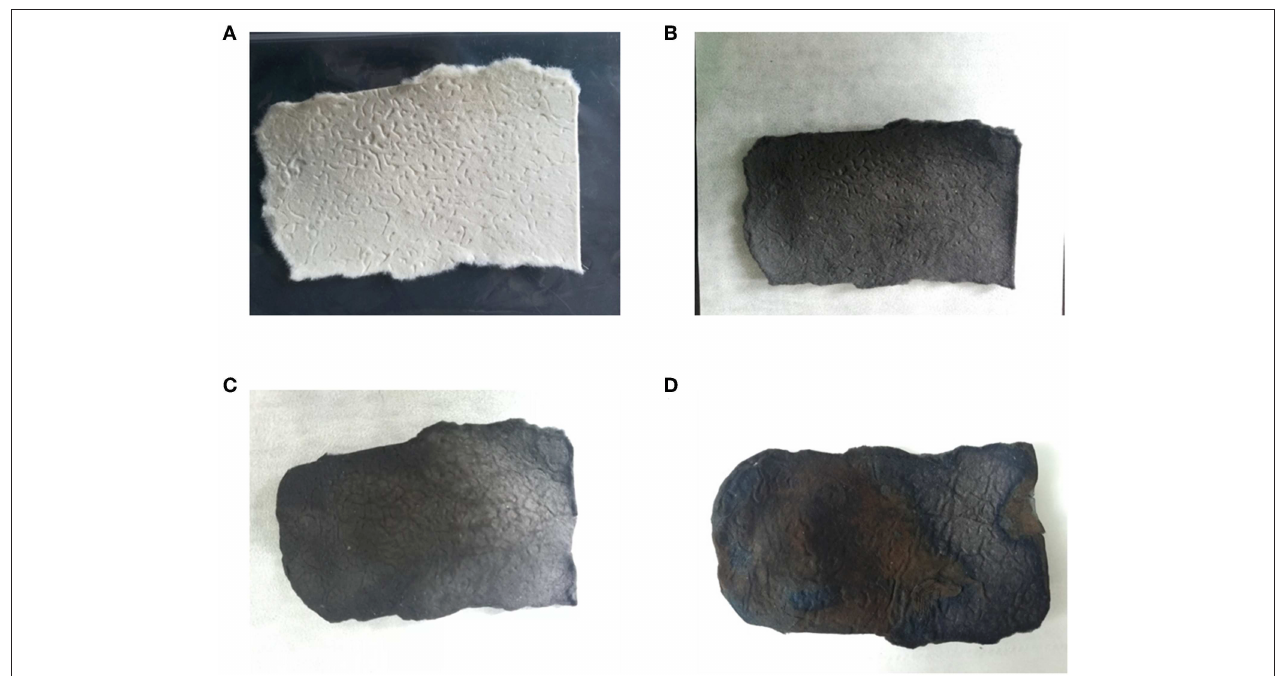
FIGURE 5 | Photographs showing the sisal hemp pulp-based paper before carbonization (A) , after carbonization (B) , after activation (C) , and after MnO 2 loading (D)